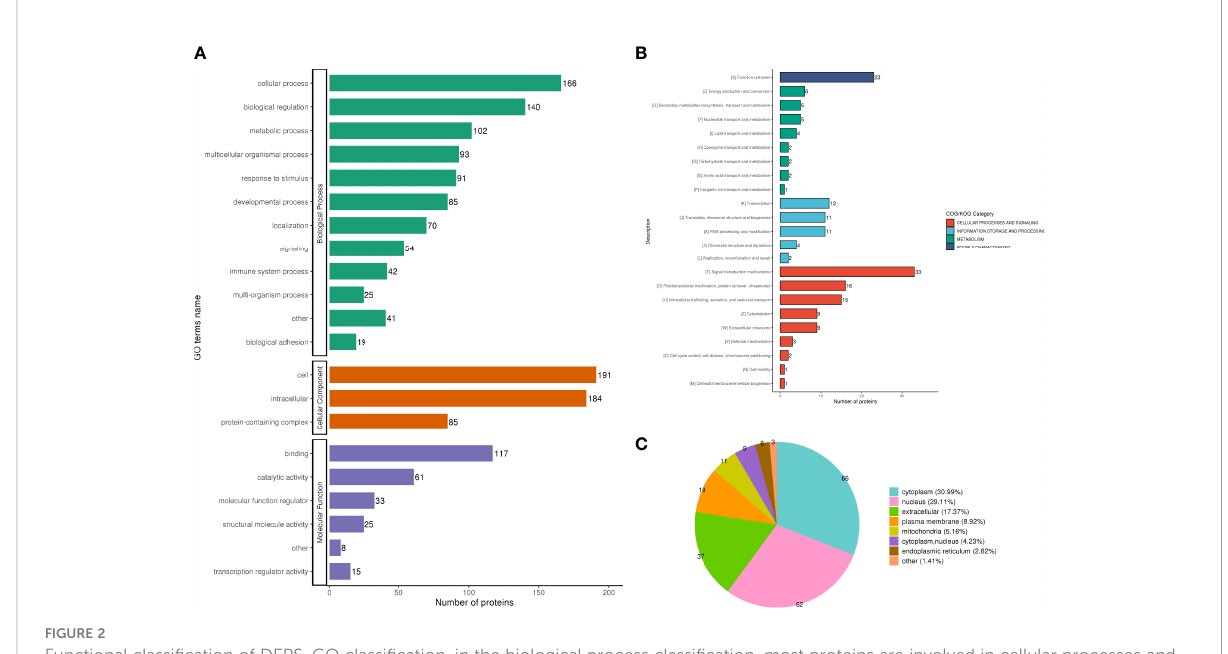
FIGURE 2 Functional classi fi cation of DEPS. GO classi fi cation, in the biological process classi fi cation, most proteins are involved in cellular processes and biological regulation; in the cellular component classi fi cation, most proteins are distributed in intracellular fl uid and protein-containing complexes; in the molecular function classi fi cation, most of the proteins are in the categories of binding, catalytic activity and molecular regulators (A) . The subcellular structure was dominated by cytoplasm and nucleus (B) . COG functional classi fi cation showed that most of the proteins were in the signal transduction machinery category (C)